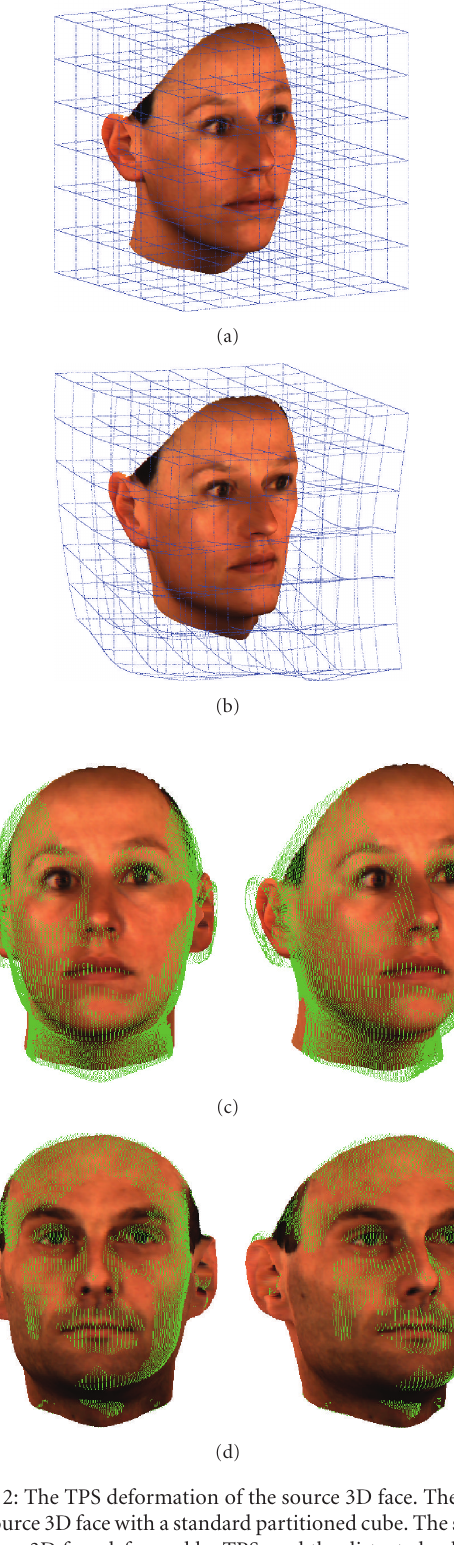
Figure 2: The TPS deformation of the source 3D face. The top one is the source 3D face with a standard partitioned cube. The second is the source 3D face deformed by TPS, and the distorted cube shows the spatial deformation of TPS. The third two are the images of the source 3D face comparing with the deformed source 3D face which displays as the sparse mesh. The bottom two are the images of the destination 3D face comparing with the deformed source 3D